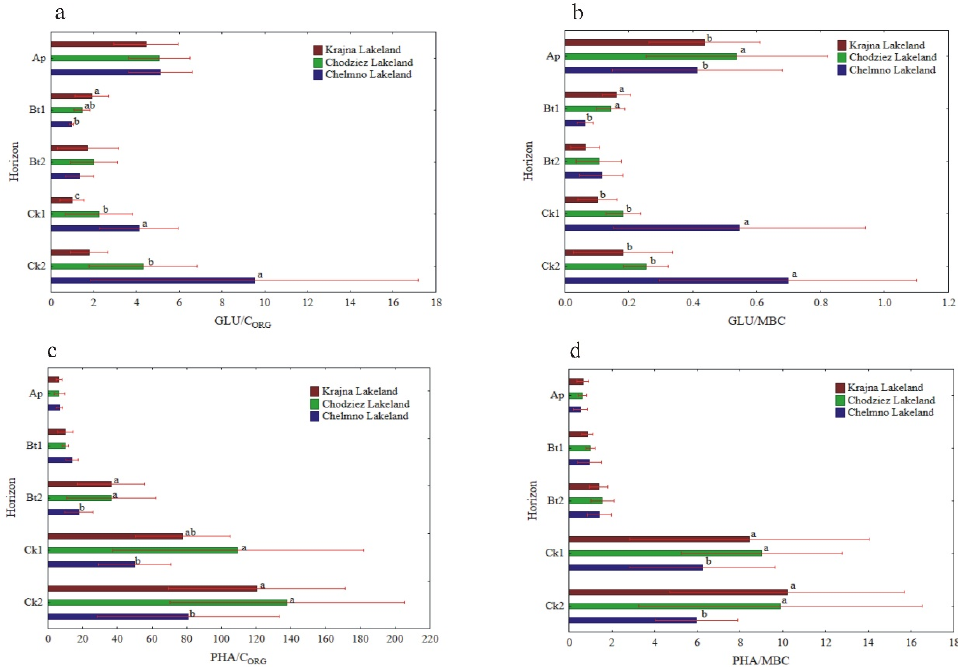
Figure 7. Activity of soil GLU and PHA at different soil horizons, expressed on an organic carbon (C ORG ) and microbial biomass carbon (MBC) basis; GLU/C ORG ( a ), GLU/MBC ( b ), PHA/C ORG ( c ) and PHA/MBC ( d ). Different lowercase letters indicate significant differences ( p < 0.05) between the study sites (within the same genetic horizon).